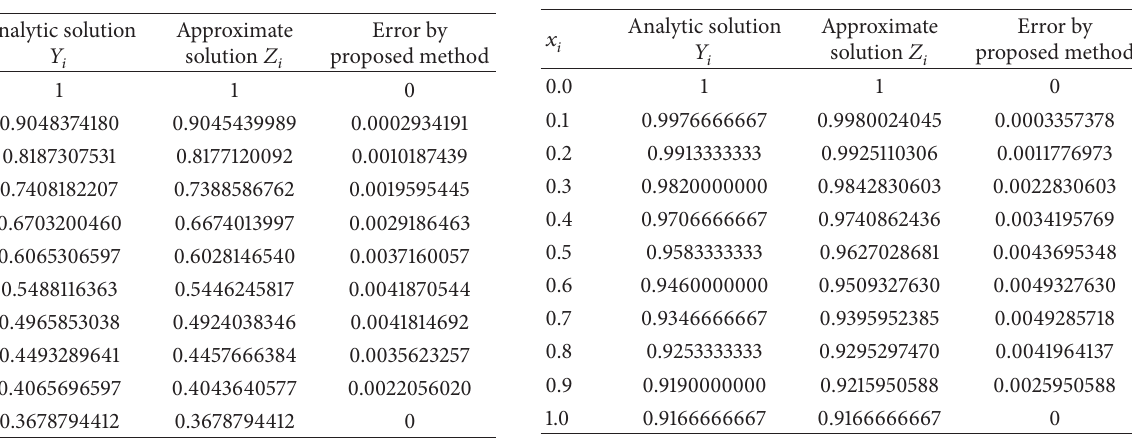
Table 3: Numerical results of Example 3: ℎ = 10 −1 .